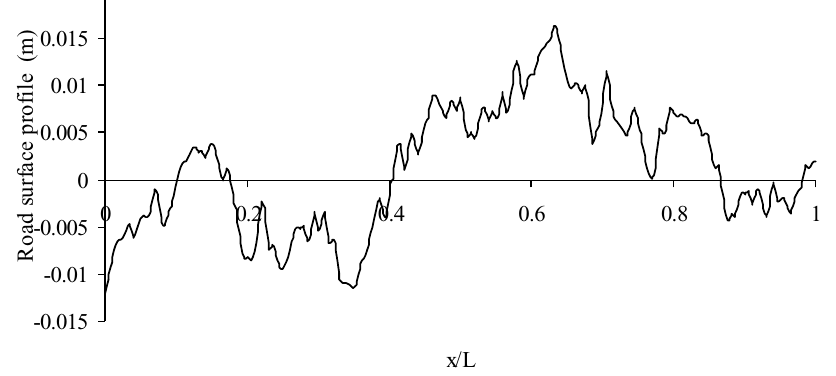
Fig. 9. A typical good road surface profile for a box girder